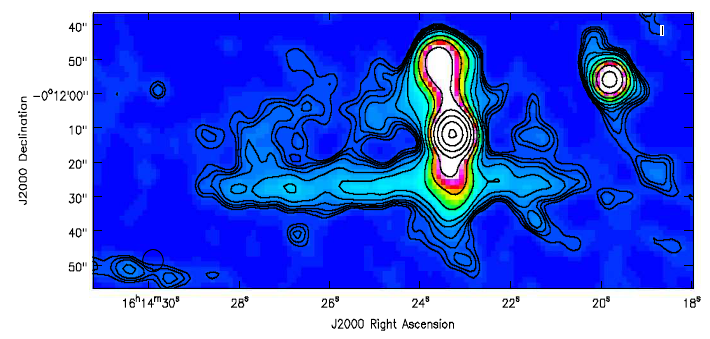
Figure 5. UGC 10288 after combining all data sets, resulting in a central frequency between L-band and C-band (4.1 GHz). The strong vertical feature near the centre is a background double-lobed source. The beam (not shown) is 6.5 arcsec in